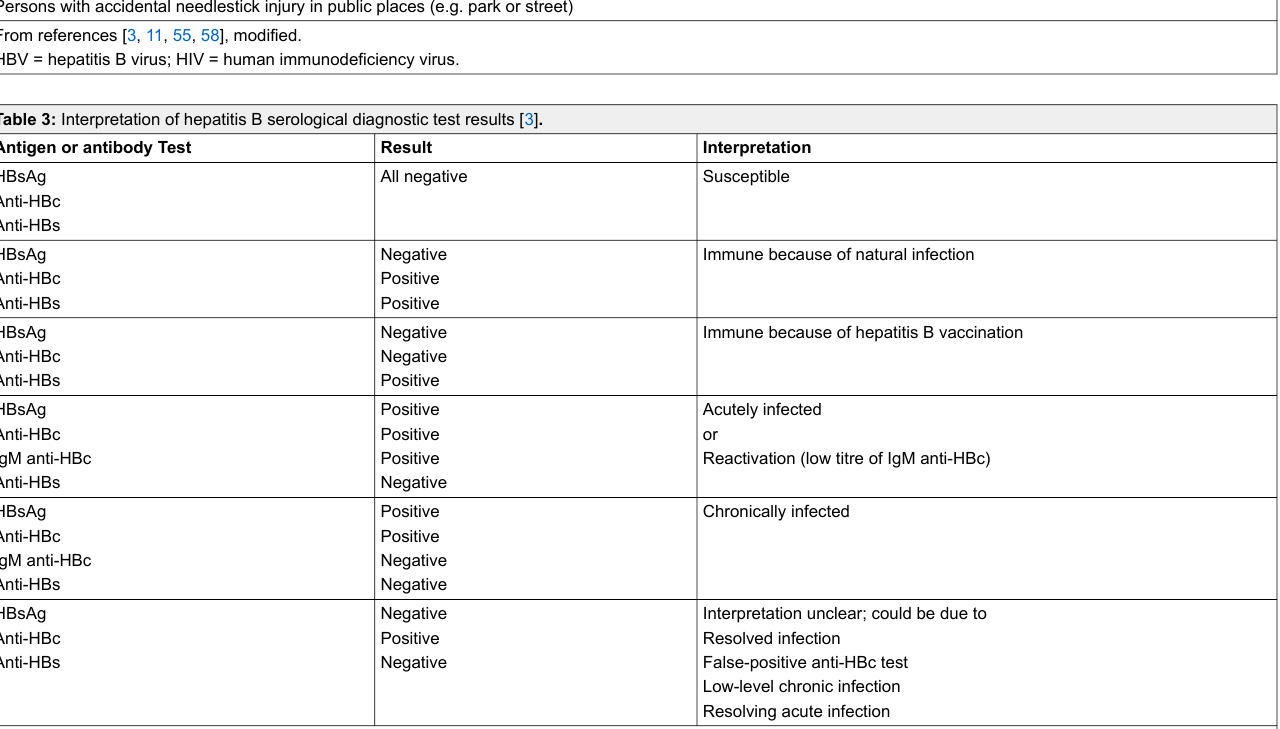
Table 3: Interpretation of hepatitis B serological diagnostic test results [3]